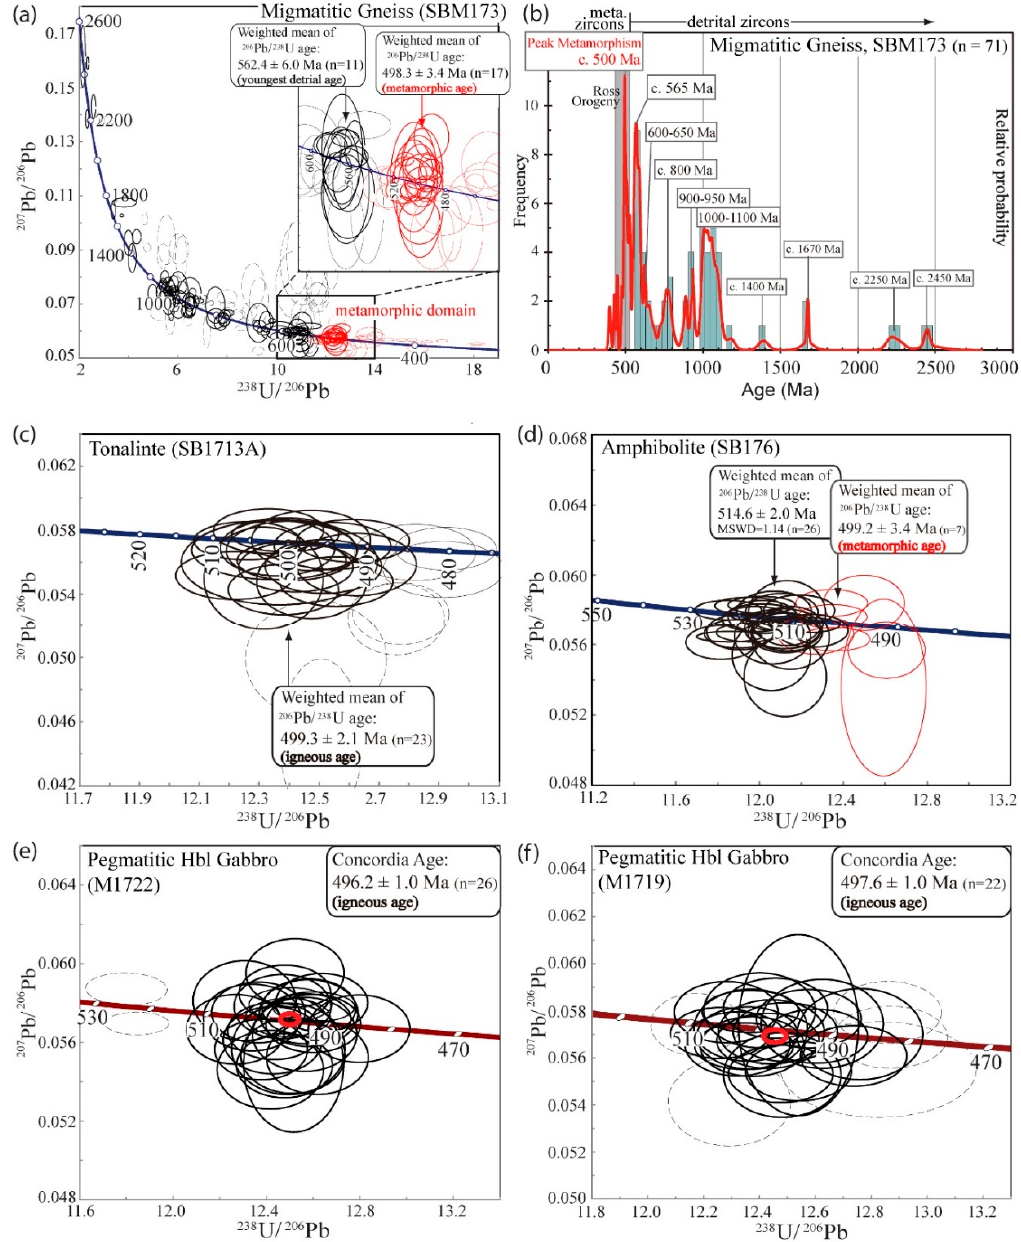
Figure 6. Tera–Wasserburg concordia diagrams showing the SHRIMP spot dates of zircon from the Mountaineer Range. ( a ) Result for the migmatitic gneiss (SBM173) from Mt. Murchison (WT), ( b ) the relative probability distribution–frequency histogram of detrital zircons and metamorphic zircons with a concordance of > 90% ( 206 Pb / 238 U ages for < 1500 Ma and 206 Pb / 238 U ages for > 1500 Ma) from the migmatitic gneiss (SBM173), ( c ) results for the tonalite (SB1713A) from the Tonalite Belt, ( d ) the amphibolite (SB176) from the Dessent Unit and ( e , f ) pegmatitic hornblende (Hbl) gabbros from the northwestern margin of the TGC